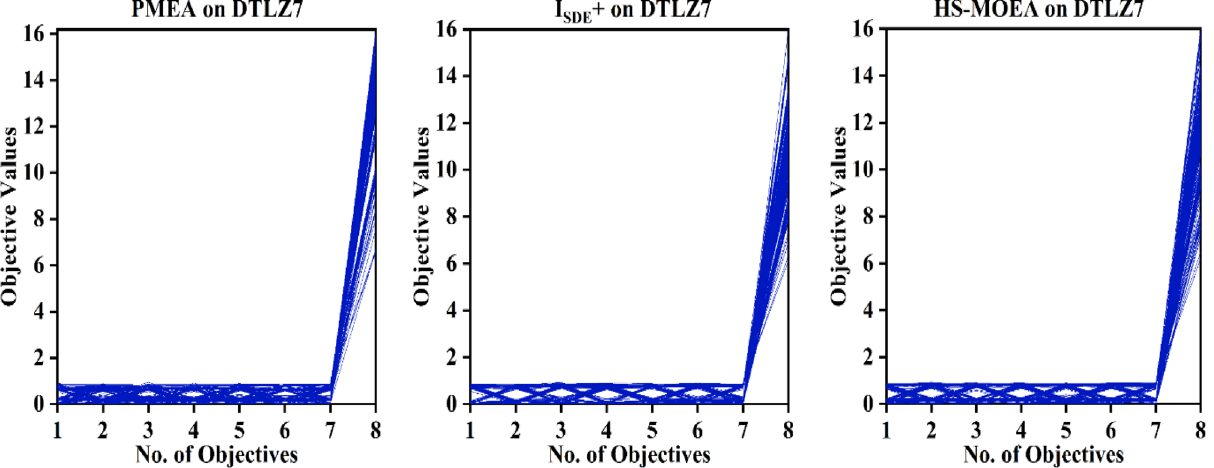
Figure 5. Parallel coordinates of the best solution set of PMEA, I SDE+ and HS-MOEA on 8-objective instance of